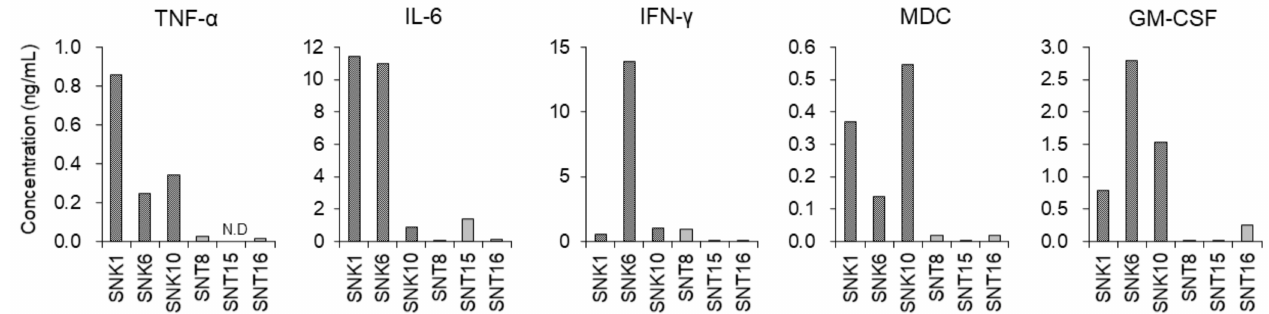
Figure 4. Identification of cytokines in the supernatants of EBV-positive T- or NK-cell lines. The cytokine concentrations in the supernatants of EBV-positive T- or NK-cell lines were examined using a cytokine multiplex assay. The concentrations of TNF- α , IL-6, IFN- γ , MDC, and GM-CSF are shown. N.D.; not